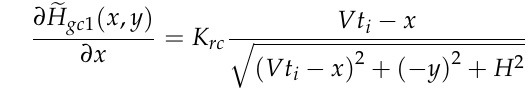
Figure 6. Flowchart of the squint minimization refocusing algorithm: 1. Align the spectrum center. 2. Correct the inclined spectrum. 3. Estimate the relative velocity γ p . 4. Perform motion compensation for the moving ship.